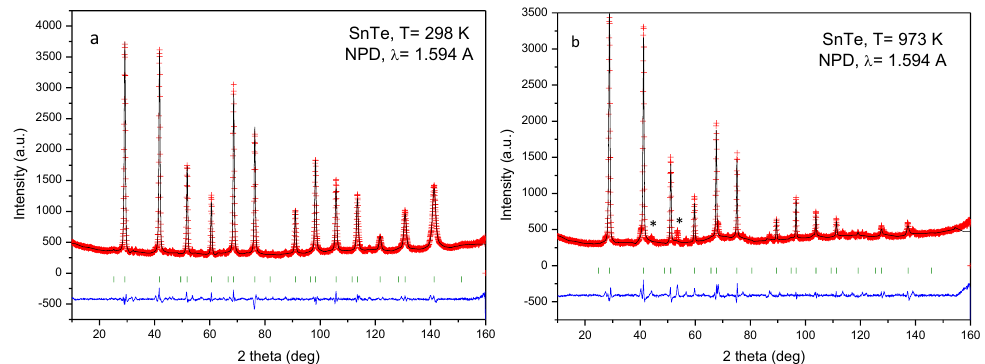
Figure 2. NPD profiles after the Rietveld refinement of the cubic crystal structure at ( a ) 298 K and ( b ) 973 K. Stars indicate unidentified impurities.